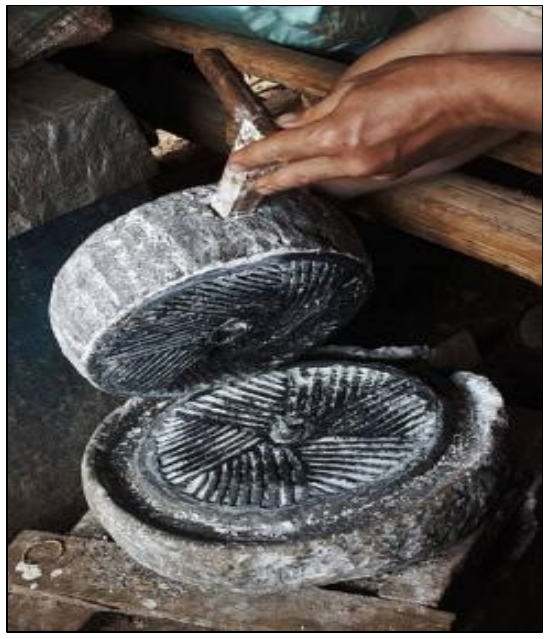
Figure 1. Hand-driven grindstones.